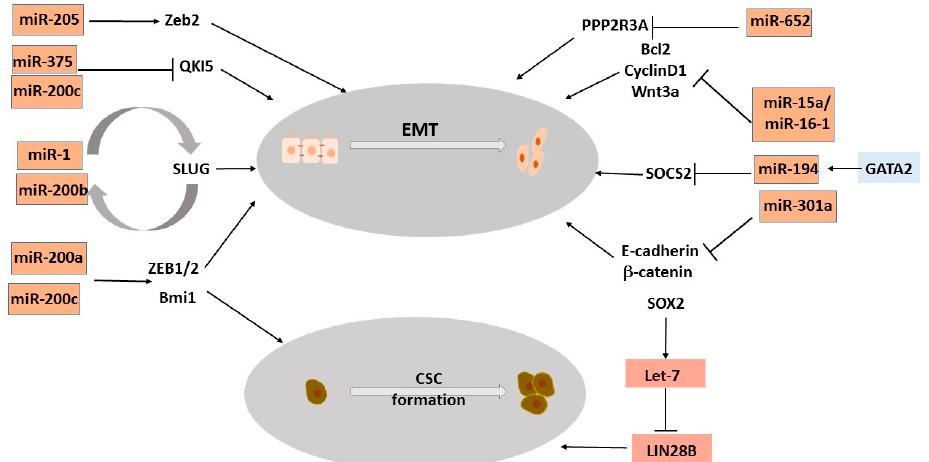
Figure 2. MicroRNAs impact EMT and cancer stemness. Schematic representation showing miRNAs affecting mRNAs of genes implicated in epithelial-to-mesenchymal transition and cancer stem cell formation.